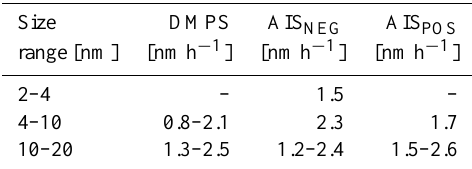
Table 5. Total particle (DMPS), negative ion (AIS NEG ) and posi- tive ion (AIS POS ) growth rates at different size sections: 2–4nm, 4–10nm and 10–20nm for class I and II events (see Table 4). The range of all the determined growth rates is presented, if the value was calculated for many event days. Note that in some events, only the growth rate of the largest particles could be determined and the ranges of growth rates are therefore not directly comparable between different size